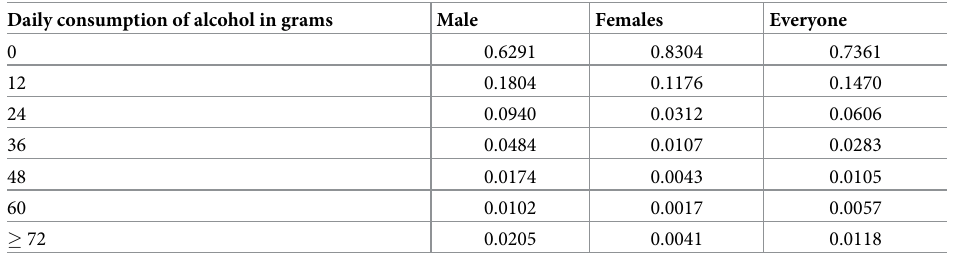
Table 2. Prevalence of alcohol intake by consumption group and sex, Brazil,